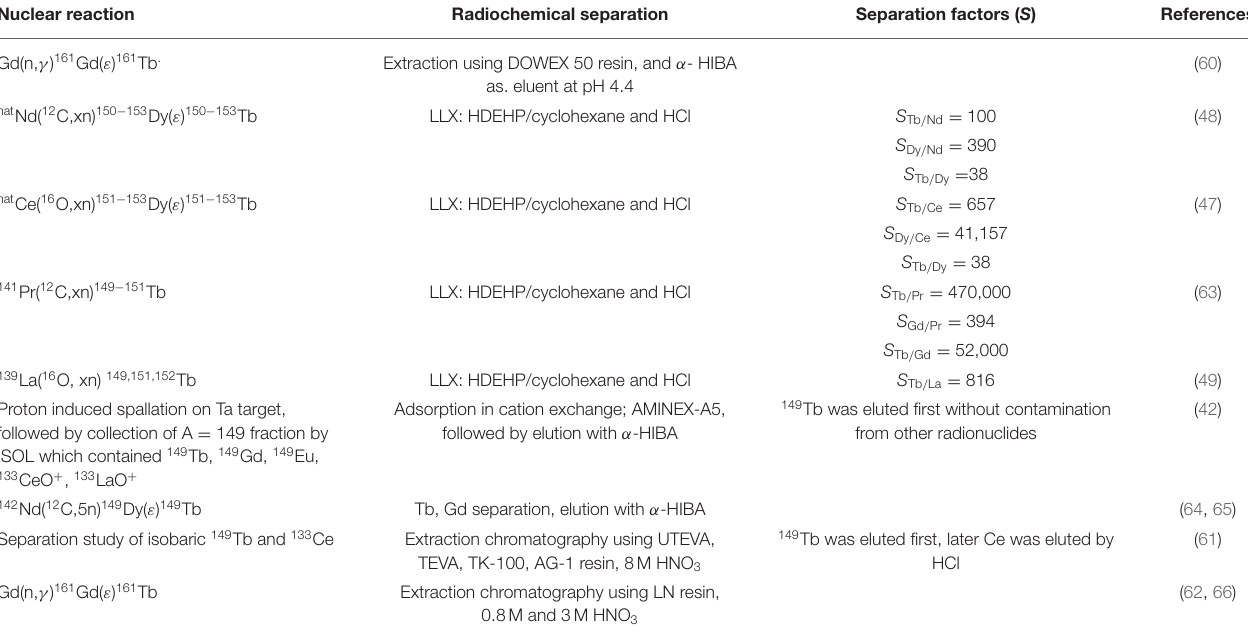
TABLE 4 | Radiochemical separation of no-carrier-added terbium radionuclides. Nuclear reaction Radiochemical separation Separation factors ( S ) Gd(n, γ ) 161 Gd( ε ) 161 Tb